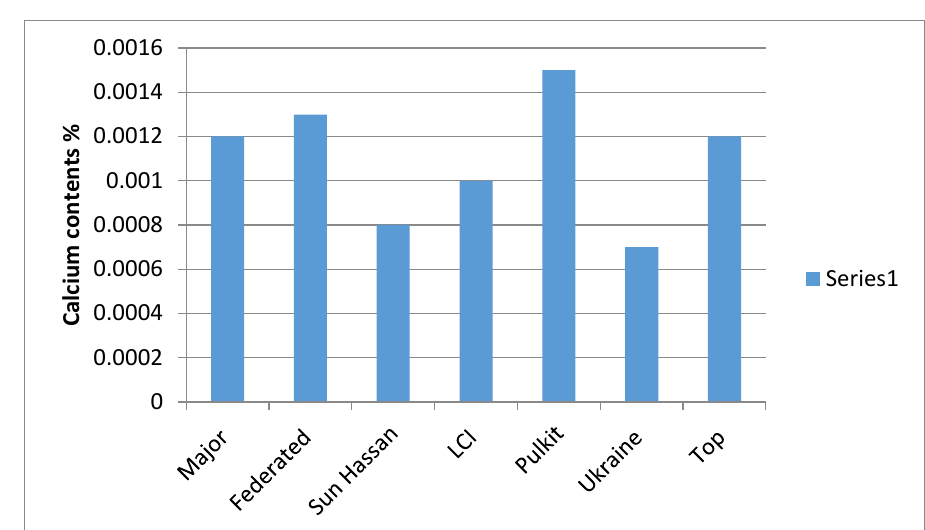
Fig. 8. Iron(Fe) content in the steel specimens.